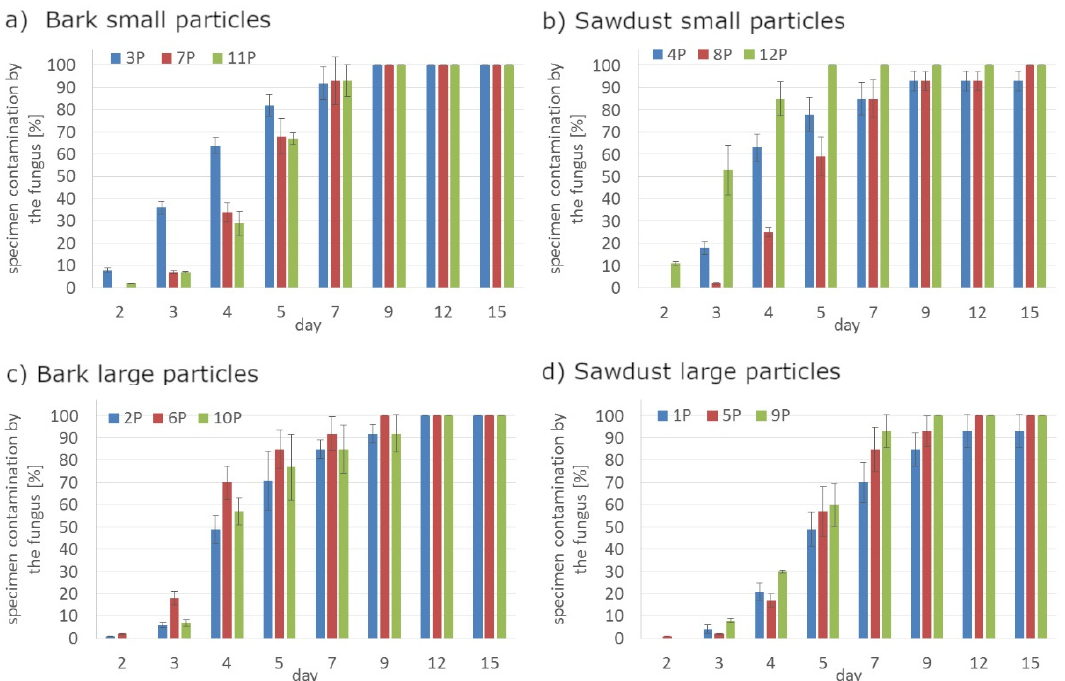
Figure 1. The rate of surface fouling by Aspergillus niger Tiegh fungi on PLA composites for: ( a ) bark small particles; ( b ) sawdust particles; ( c ) bark large particles; ( d ) sawdust large particles.